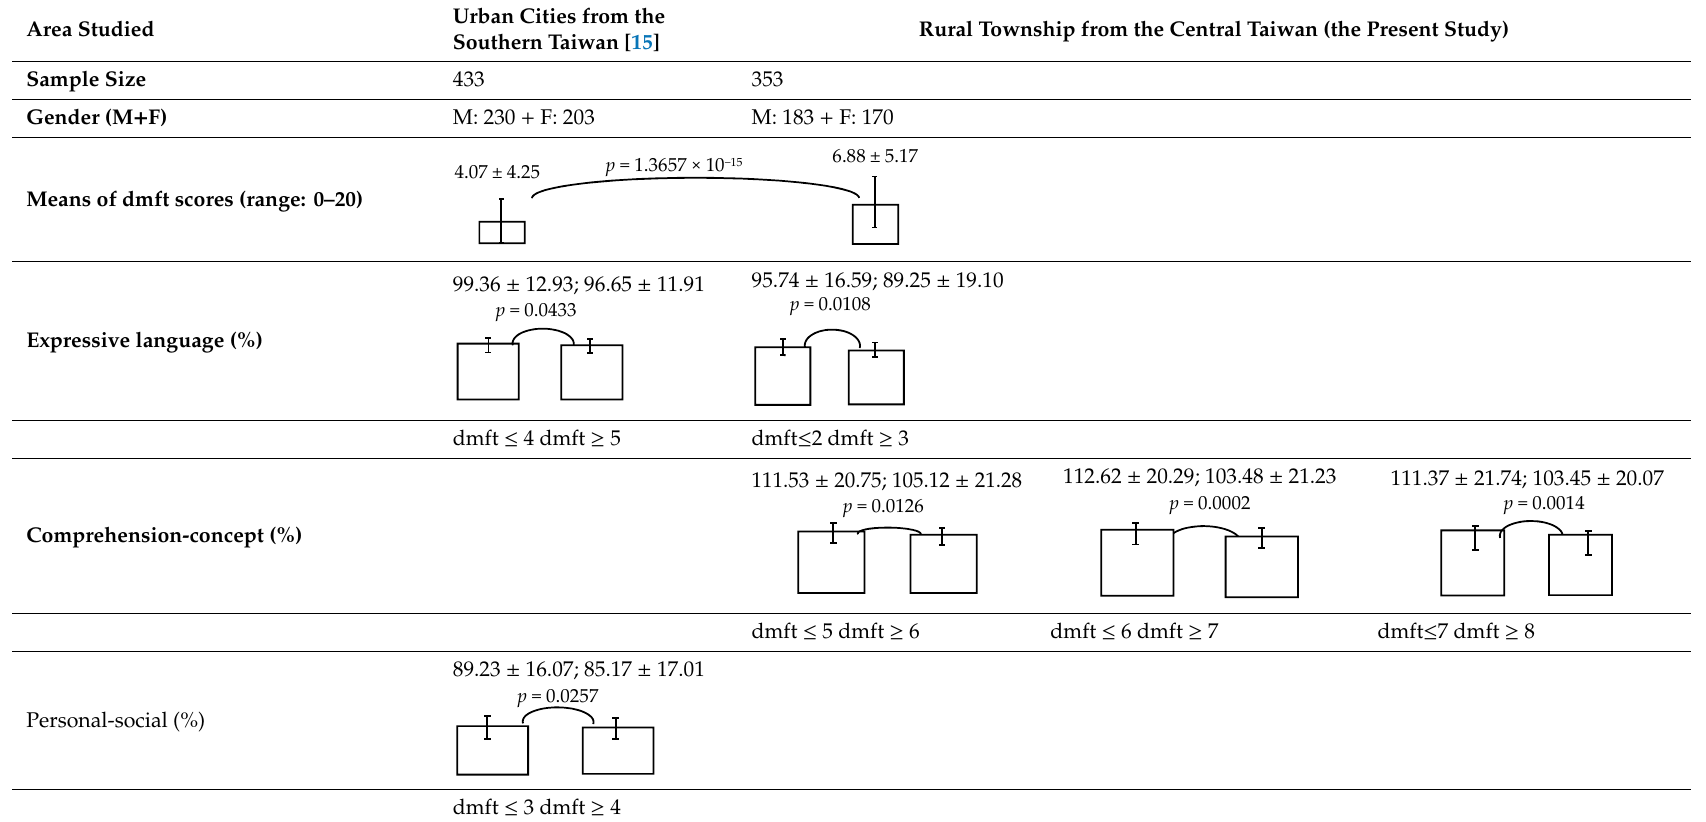
Table 5. The cross-sectional bi-township analyses, for a parallel comparison, with the resulting statistically significant differences detected, as depicted below. Area Studied Urban Cities from the Southern Taiwan [13] Rural Township from the Central Taiwan (the Present Study) Sample Size